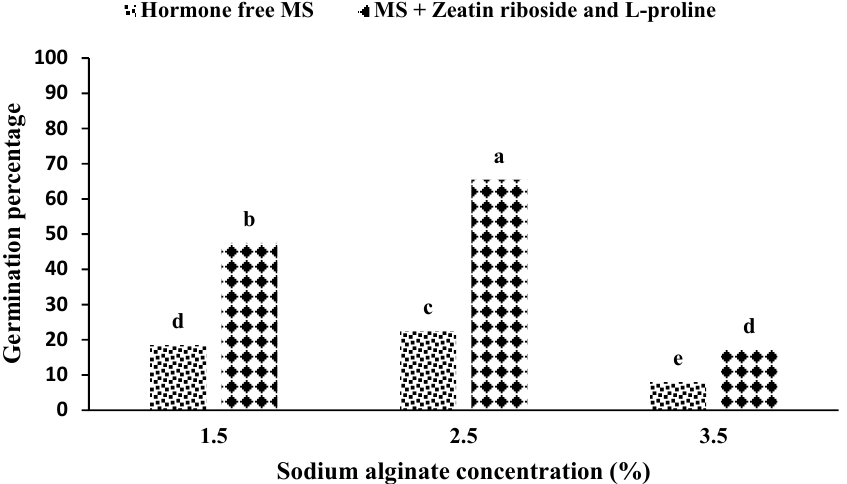
Figure 2. The mean comparison of germination percentage under the influence of germination medium and sodium alginate concentration in artificial seeds of S. pennata . Bars with a common letter do not differ significantly from each other. p < 0.01 probability level (Duncan’s